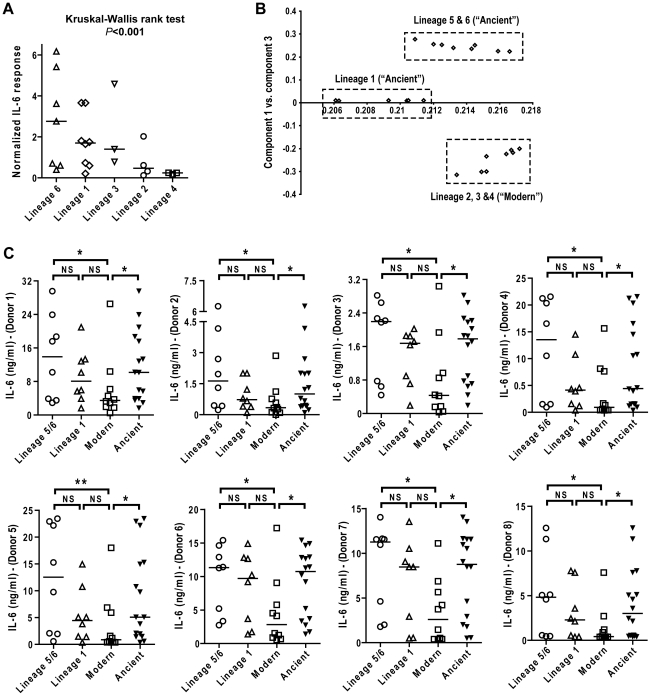
IL-6 production varies with genetic clustering of MTBC lineages.A) Median normalized levels of cytokine production by human monocyte-derived macrophages from eight independent donors were averaged for scatter plot representation and clustered according to strain lineage. Non-parametric Kruskal-Wallis test revealed a significant effect of lineage variable in cytokine production (P<0.001). B) PCA plot (PC1 versus PC3) of the strains used in this study based on the polymorphisms found between them in Hershberg et al. 2008 highlights three main groups clearly separating the three modern lineages from Lineage 1, and from the two M. africanum lineages (5 and 6). C) IL-6 response from T1-MDMs from eight donors infected by the panel of MTBC strains indicates that Lineages 5+6 and Lineage 1 induce more IL-6 than the modern lineages. (Mann-Whitney U test, * P<0.05, ** P<0.01).